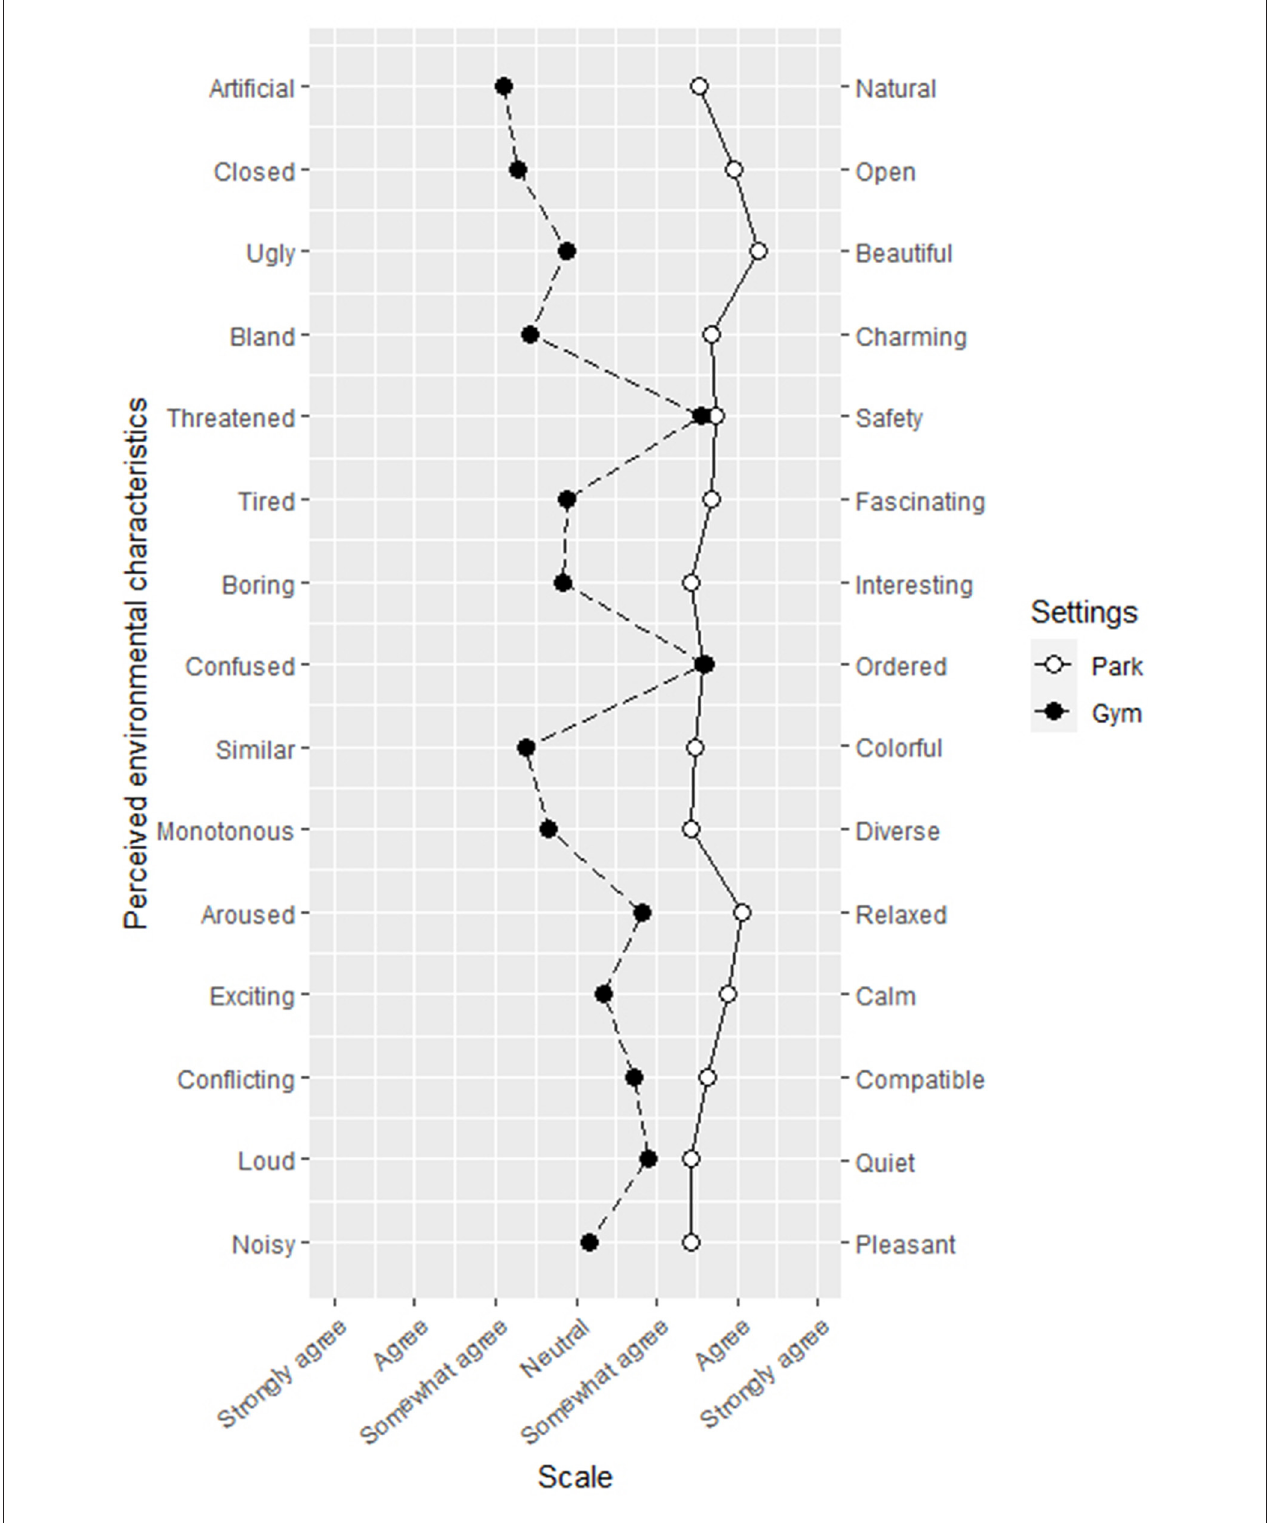
FIGURE 7 | Measurements for the perception of park and gym settings while walking fast using semantic differential scales.